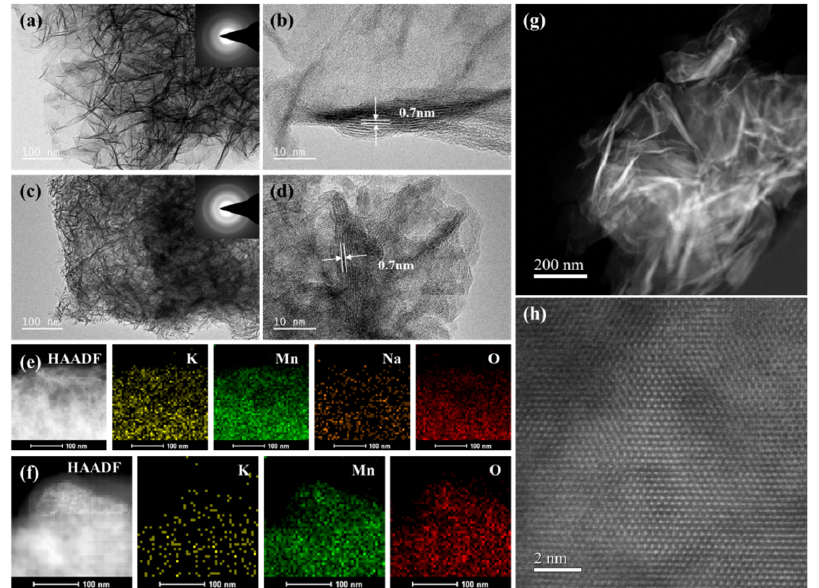
Figure 3. ( a , c ) TEM image of Na 3 -MnO 2 ; ( b , d ) HRTEM image of Na 3 -MnO 2 ; ( e ) elemental mapping of Na 3 -MnO 2 ; ( f ) elemental mapping of MnO 2 ; ( g , h ) HAADF-STEM images.